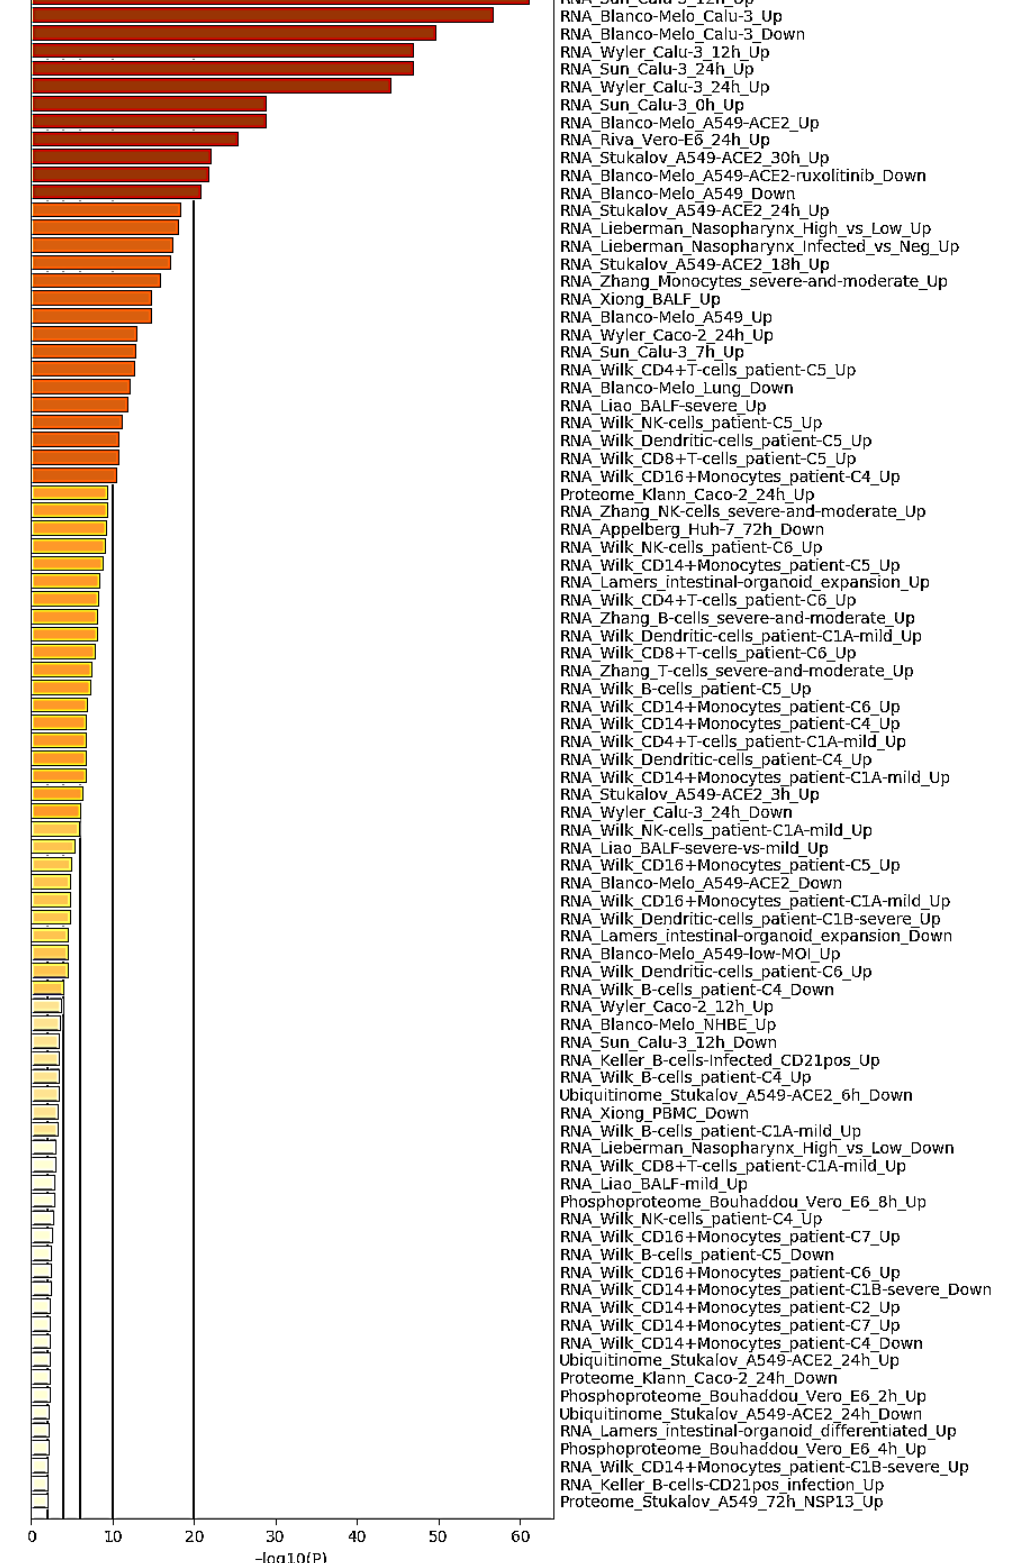
Figure 2. Summary of gene enrichment in COVID-19 analysis. Terms with a p -value < 0.01, a minimum count of 3, and an enrichment factor >1.5 (the enrichment factor is the ratio between the observed counts and counts expected by chance) were collected and grouped into clusters based on membership